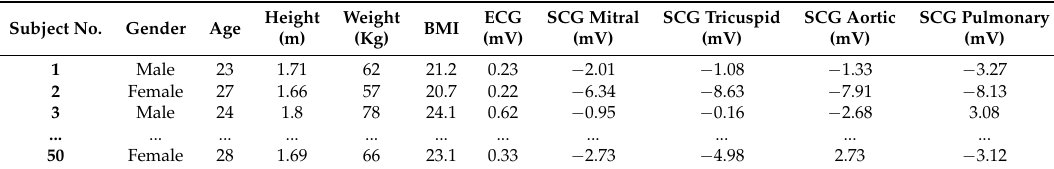
Table 3. Demographic snapshot of the